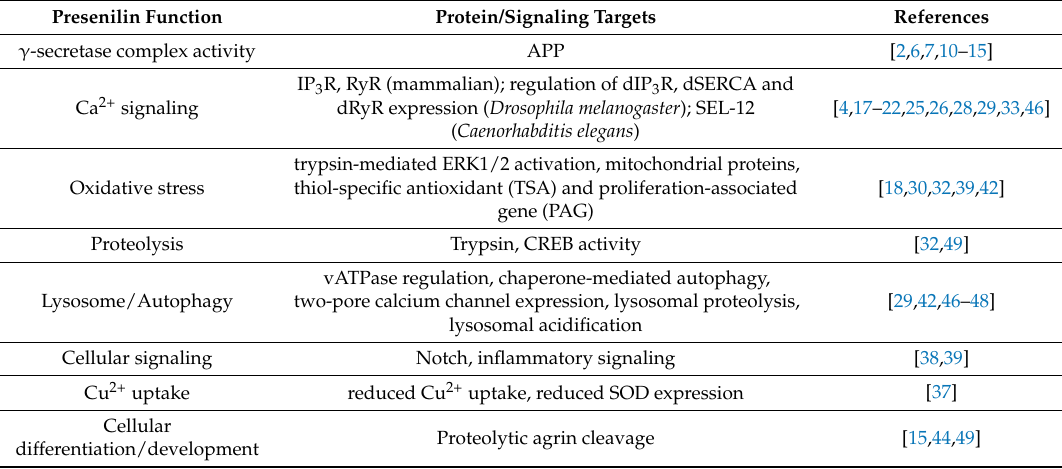
Table 1. Presenilin function within